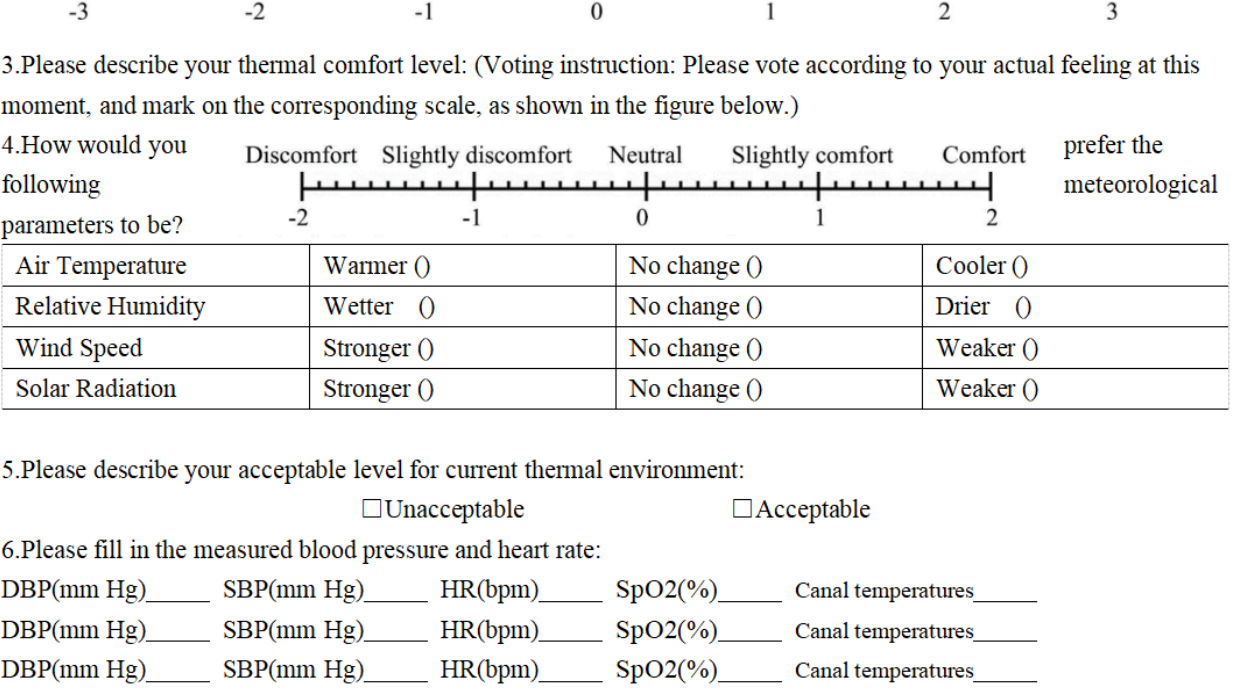
Figure 3. Questionnaire survey.